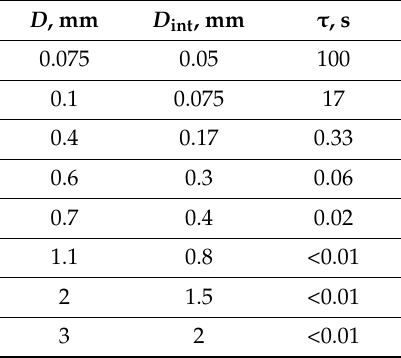
Table 1. Pitot tube size and relaxation time.